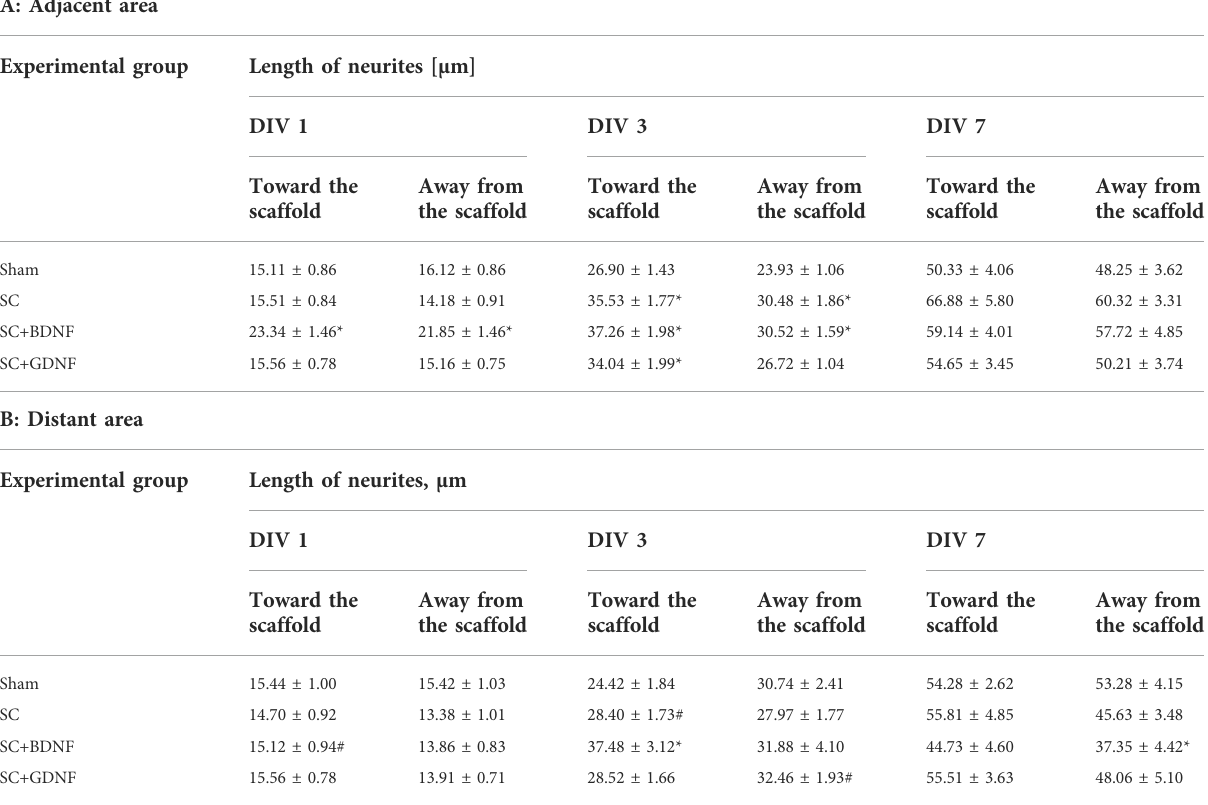
TABLE 1 Dynamics of the development of neuronal processes in the primary hippocampal cultures in the early stage of cultivation in vitro. A: Adjacent